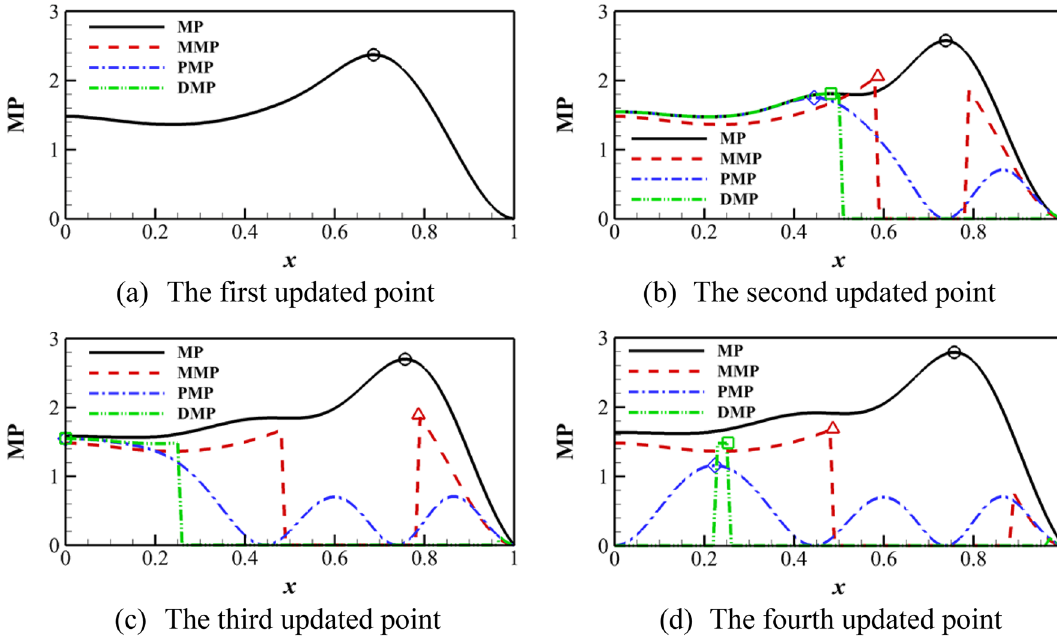
Figure 4. MMP, PMP, DMP algorithm on Forrester function compared with the standard